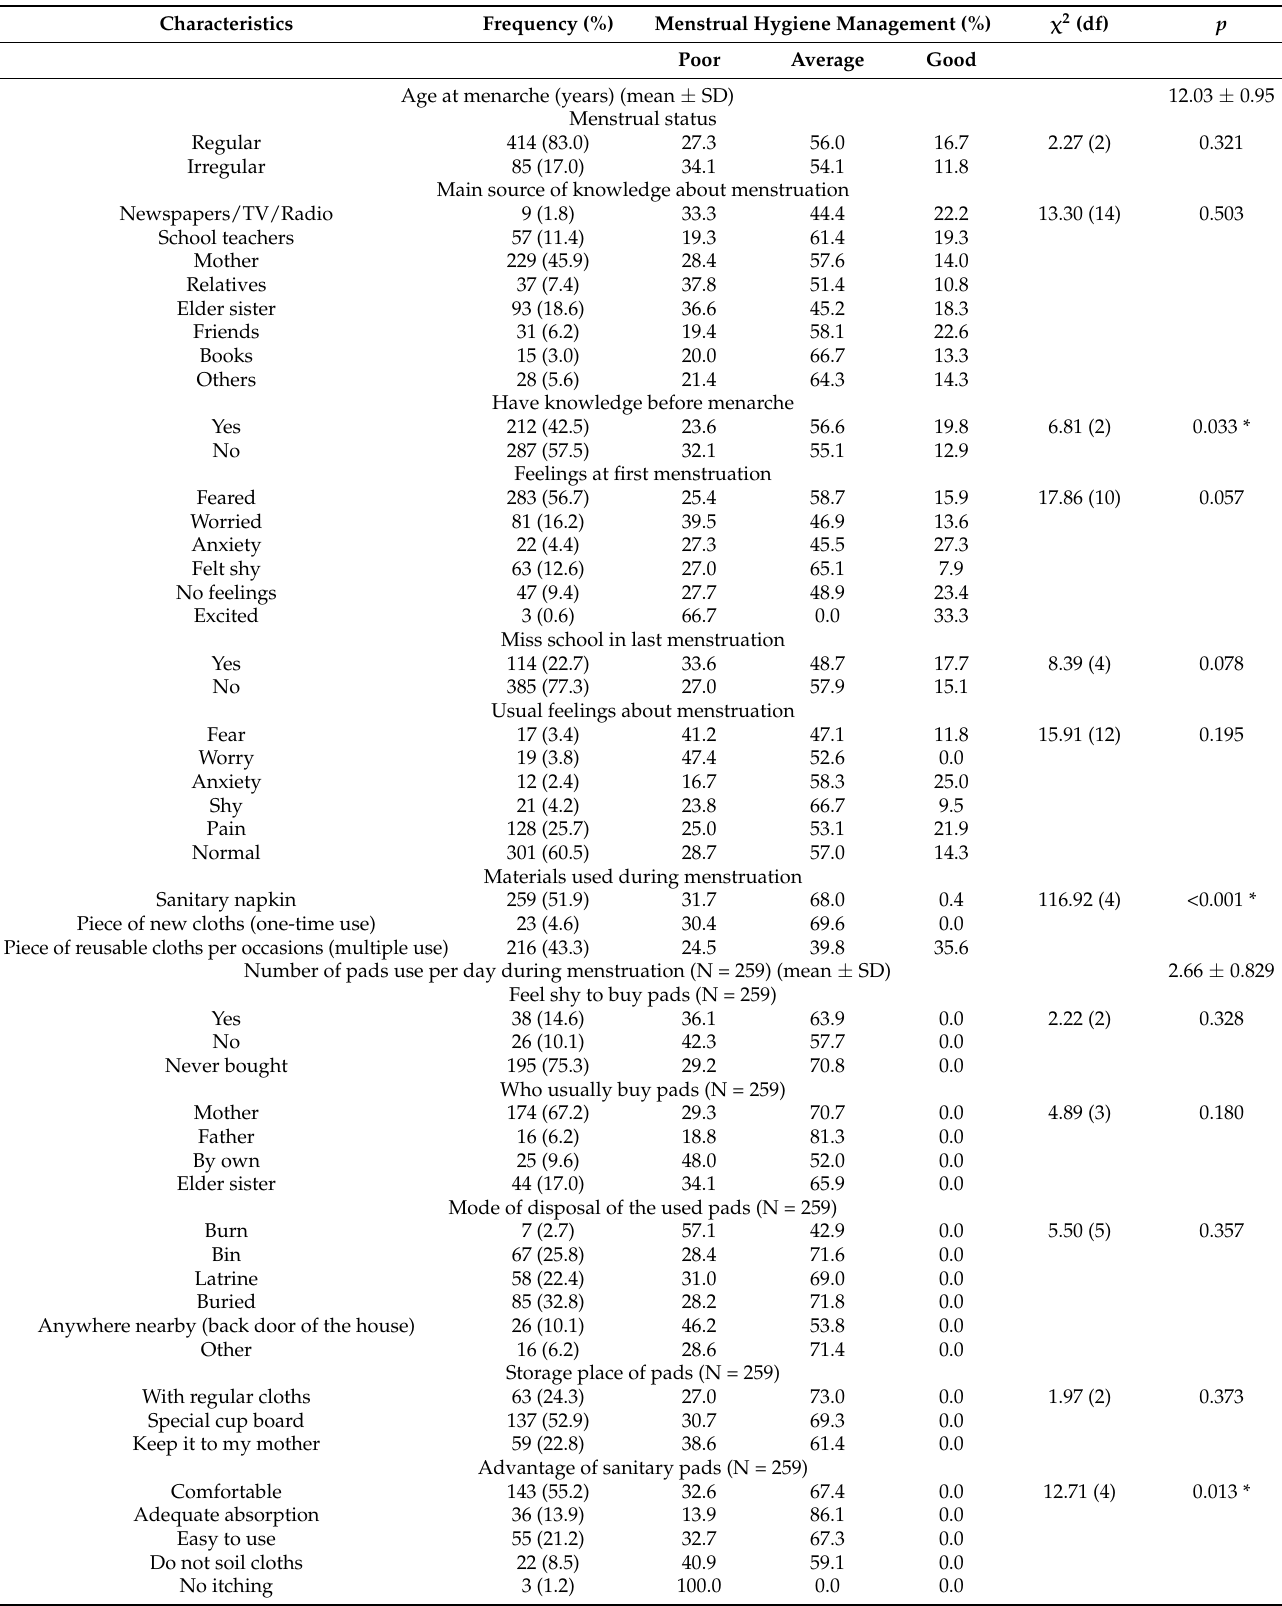
Table 2. Menstrual information of the girls and association with menstrual hygiene management.